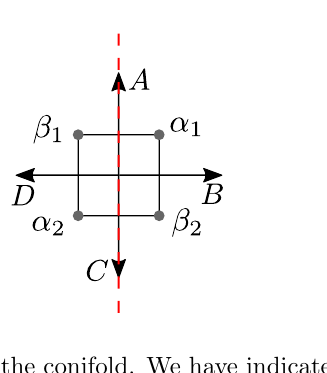
Figure 1 . Toric and web diagram for the conifold. We have indicated the action of the orientifold involution studied in the text by the vertical red dashed line. The external legs in the web diagram are labeled for later